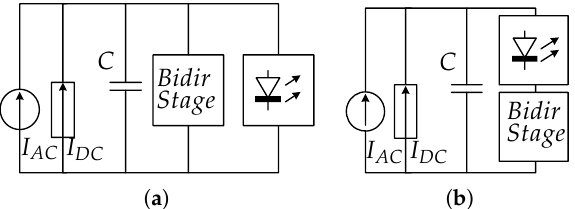
Figure 1. Connection options for bidirectional converter. ( a ) Parallel connection. ( b ) Series